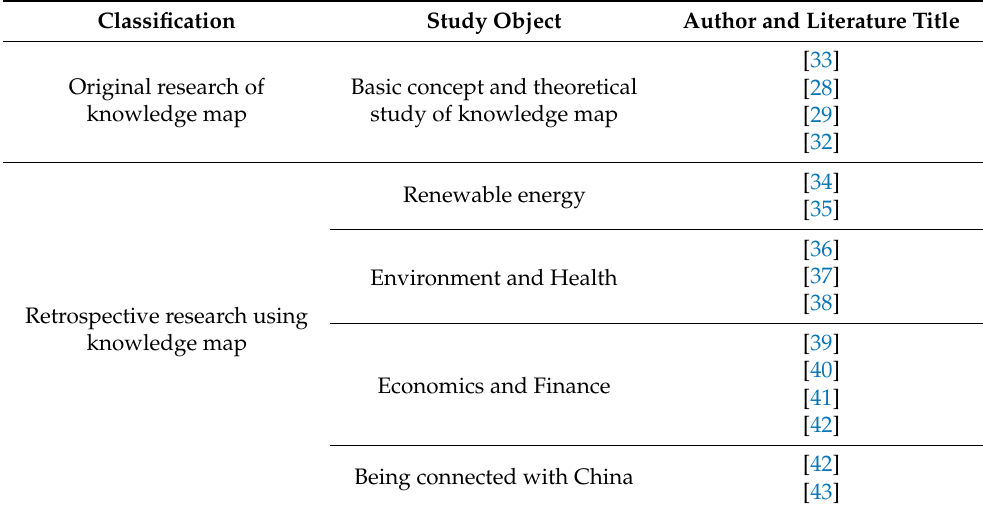
Table 1. Representative literature on knowledge map and FTZ